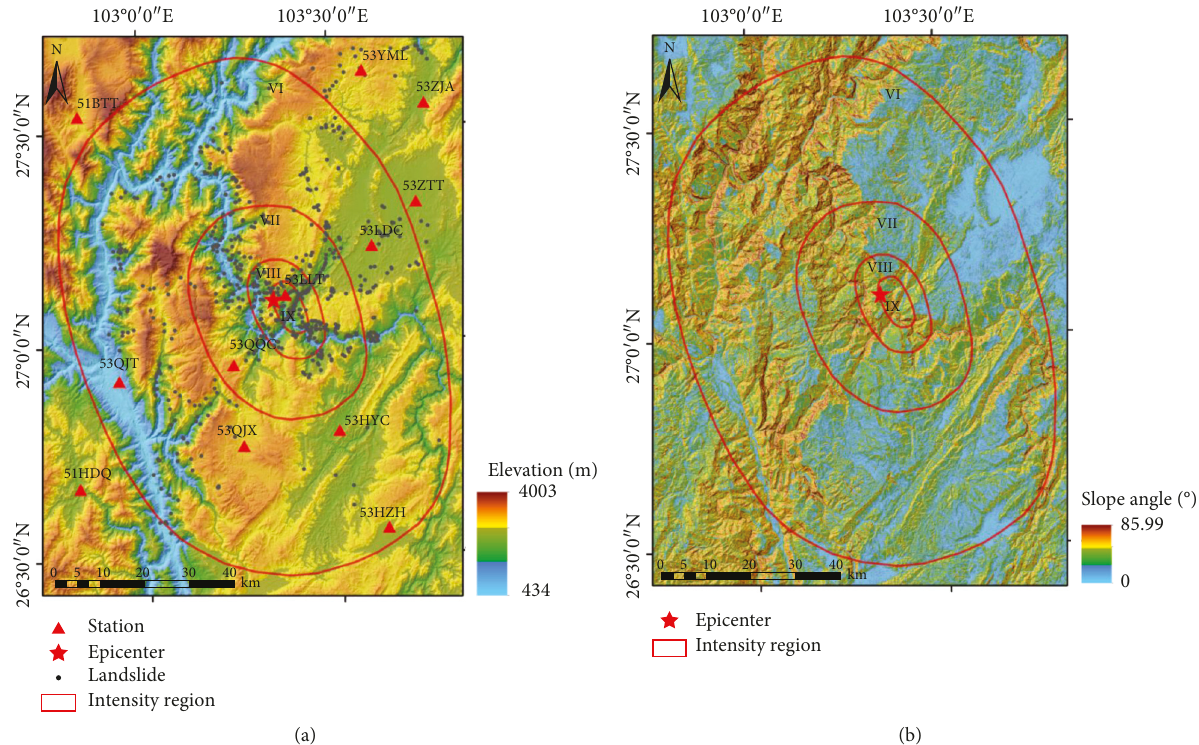
Figure 3: Distribution of elevation, slope angle, and intensity map in Ludian earthquake. (a) Elevation and intensity map. (b) Slope angle and intensity map.